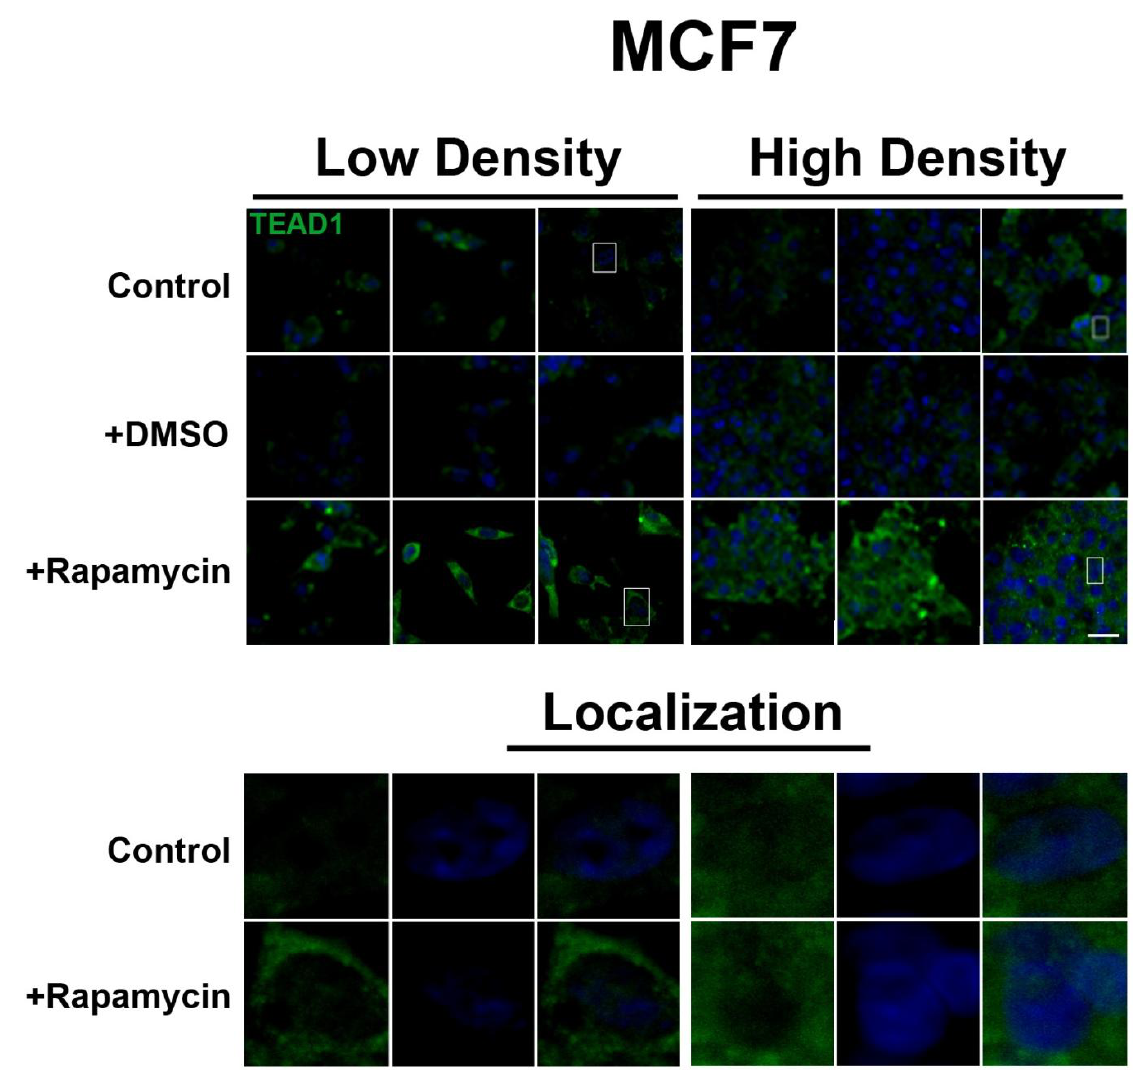
Figure 3. mTOR pathway inhibition increases TEAD1 levels in MCF7 cells. Elevated levels of TEAD1 (green) were observed at both high and low cell densities after treatment with rapamycin. Bottom panels represent the boxes in top images: localization of TEAD1 at low and high cell density conditions demonstrates cytoplasmic localization that does not change with rapamycin treatment. TOPRO3 (blue) labels nuclei. Scale bars,